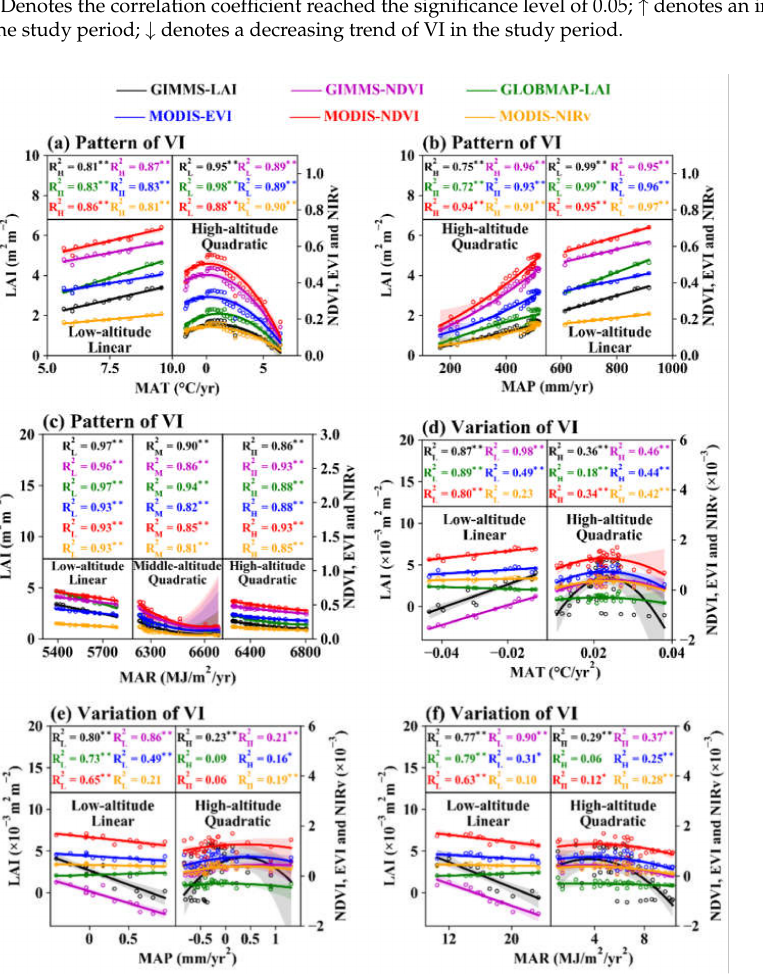
Figure 10. Effect of climate on the spatial patterns and slopes of VI in elevational gradients. Subfigures illustrate the scatter points and their fitting curves of the correlation between climate and VI spatial patterns ( a – c ) and slopes ( d – f ) in elevational gradients. The determination coefficients of VIs and climate are shown at the upper part of each subfigure. The shadow region of each line denotes the 95% confidence